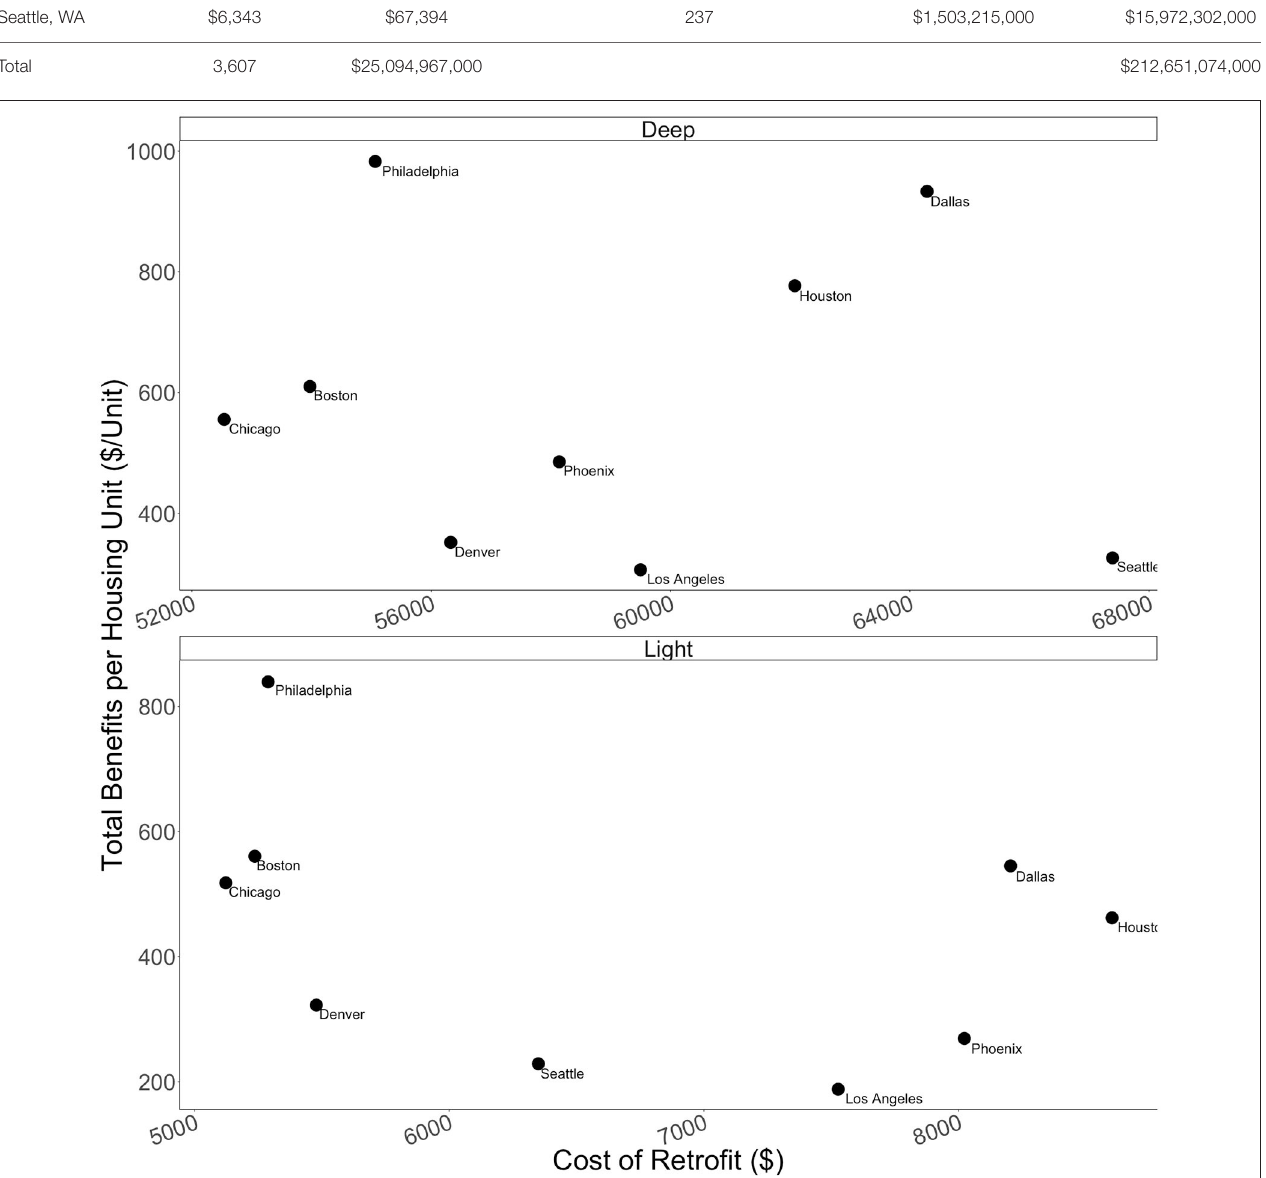
FIGURE 8 | Total annual cost (2016 USD) of deep (top) and light (bottom) heat adaptation retrofits per single-family detached housing unit (1990–2010) and total benefits (climate, health, and utility savings) from heat adaptation retrofits per detached single-family homes built from 1990–2010.